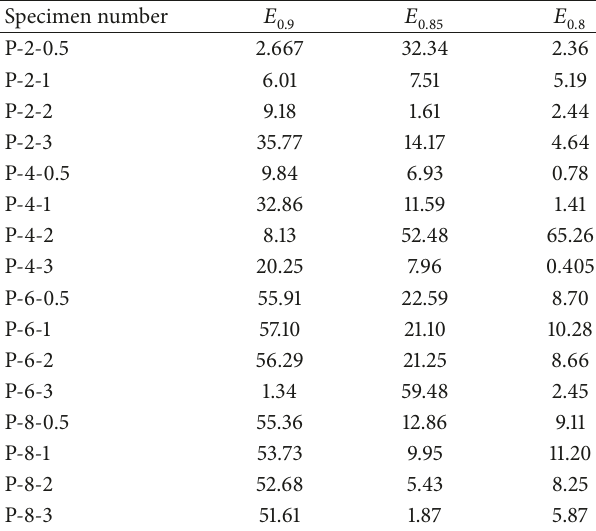
Table 6: Distribution table of relative errors